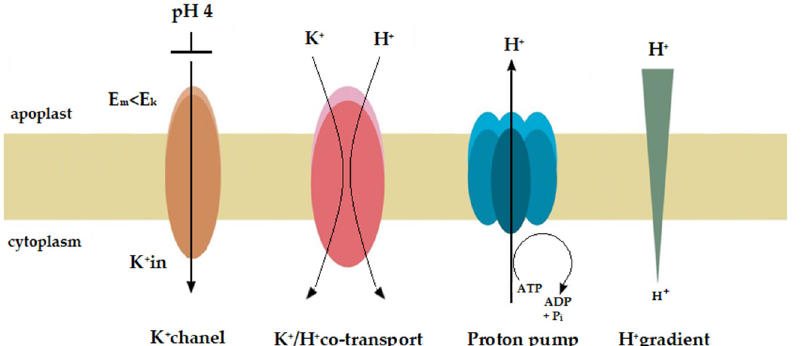
Figure 8. Hypothetical model for the molecular mechanisms of acid- and auxin-induced rapid growth. This model assumes that the K + /H + co-transporters are responsible for the acid-induced rapid growth, while both the K + channels and K + /H + co-transporters are involved in the auxin-induced growth. On the basis of the available and our own results, we speculate that at high H + concentration in the medium (pH 4) the proton pump current amplitude decreases and the membrane potential (E m ) shifts to less negative values (here from − 110 to ca. − 50 mV, Figure 7). At a K + concentration in the cytosol of 100 mM and an extracellular K + concentration of 1 mM (in our experiments) the equilibrium (Nernst) potential for K + (E K ) is equal − 118 mV, suggesting that at E m more positive than E K (here E m about − 50 mV at pH 4) the K + rectifying inward channels are blocked. Taking into account that an acid buffer (pH 4) caused the rapid and strong growth of the coleoptile segments, it may be suggested, that the K + /H + co-transporters are responsible for the acid-induced growth. However, when auxin was added to the incubation medium, it induced (after initial depolarization) a rapid (transient) hyperpolarisation of the E m (Figure 5) during which the membrane potential was by ca. 20 mV more negative than E K . This means that in the presence of IAA the inward rectifying K + channels are open and can mediate K + uptake into the cell. Because the kinetics of the IAA-induced hyperpolarisation is similar to that of the first (very rapid) phase of the IAA-induced growth it may be suggested that the inward rectifying K + channels are involved in the phase. The onset of the second phase of IAA-induced growth rate (Figure 3) correlates in time with rapid depolarisation of the E m observed here after the maximum of the IAA-induced membrane hyperpolarisation was achieved. This finding (transient membrane hyperpolarisation) may indicate that the K + /H + co-transporters are responsible for the second phase of the IAA-induced growth.